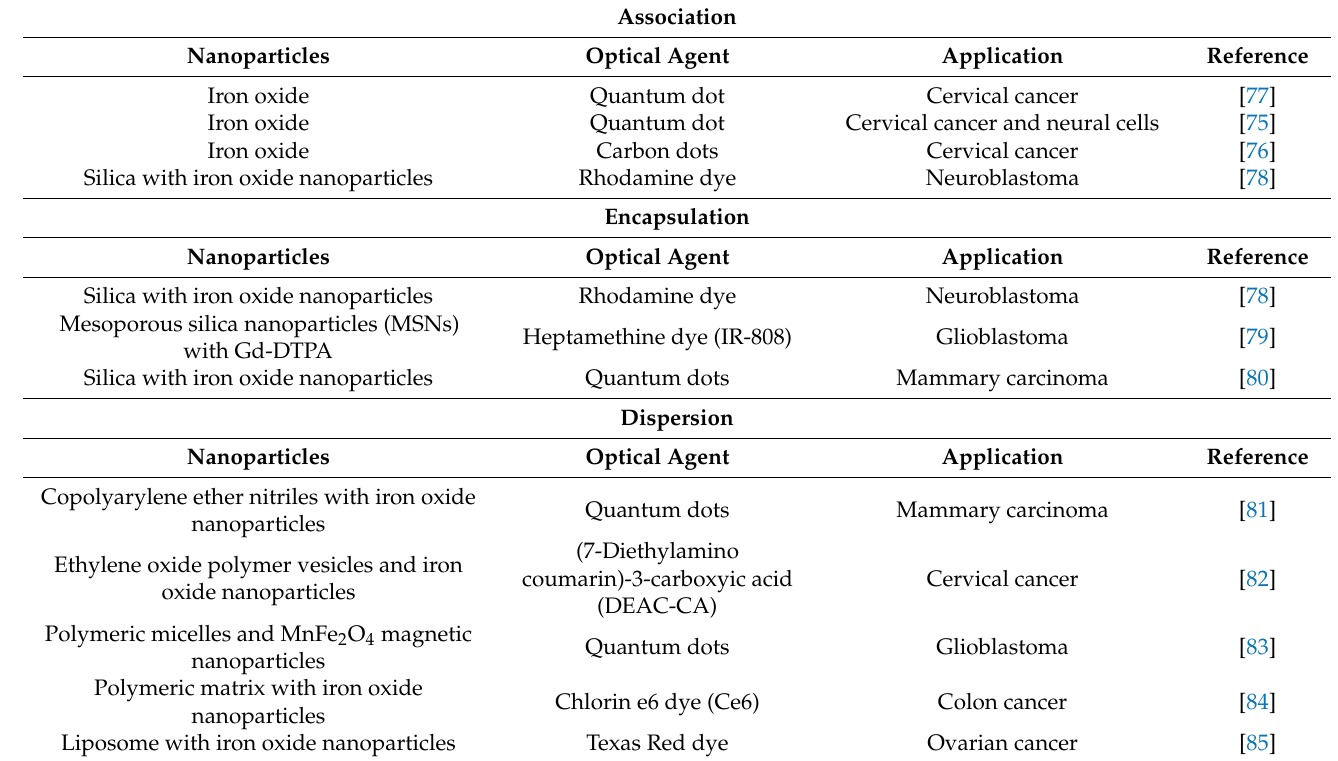
Table 2. Examples of the major methods of synthesizing magneto-fluorescent hybrid